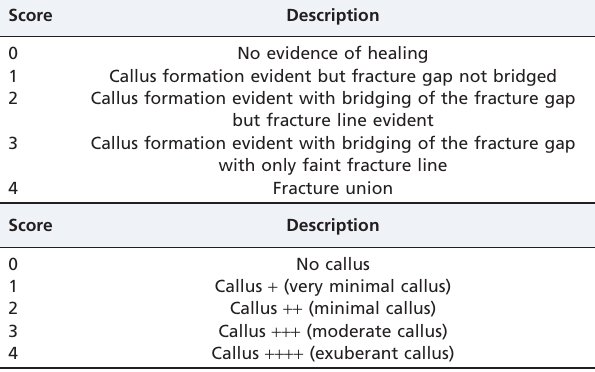
Table 1 - The 5-point radiographic scoring system (modified from Warden et al. 2009) used to assess (A) the fracture healing stage and (B) the callus stage (Nazrun et al. 2010) .